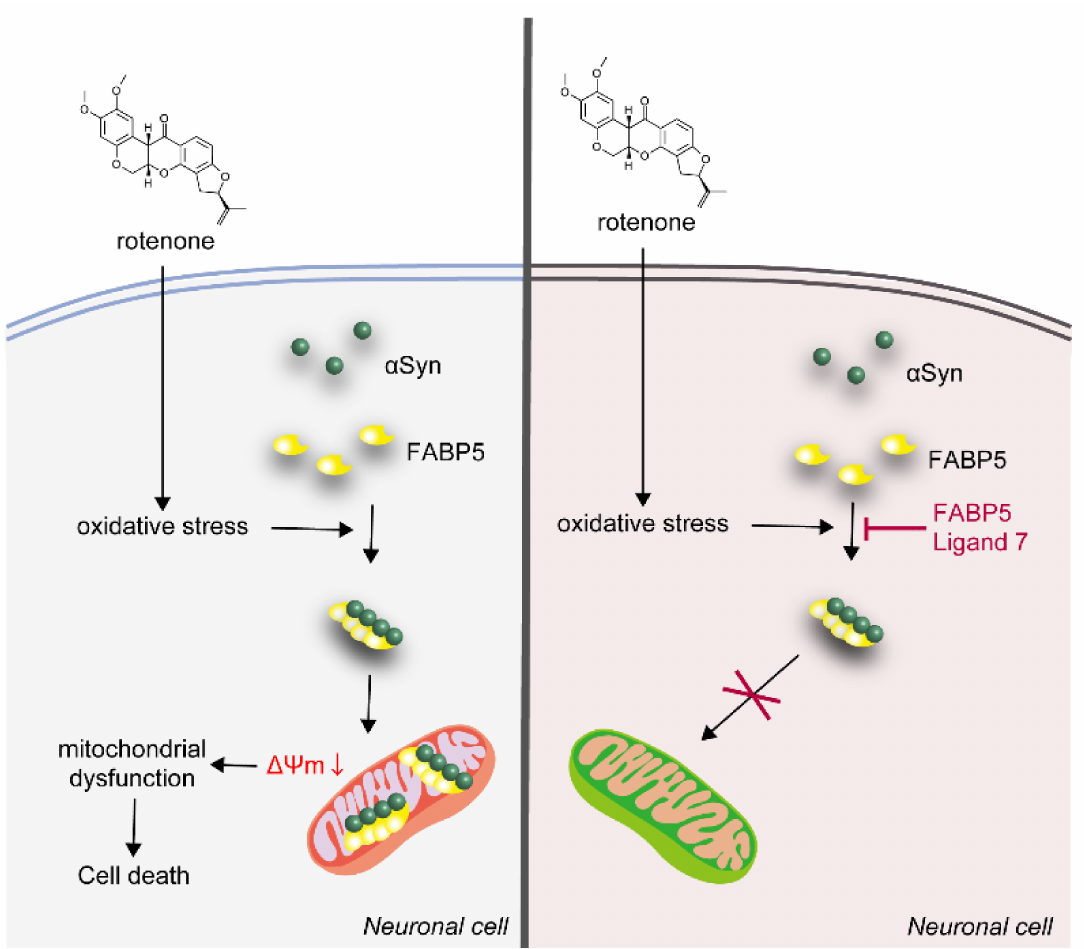
Figure 7. Schematic diagram of the mechanism by which α Syn/FABP5 aggregates aggravate mitochondrial dysfunction and induce neuronal cell apoptosis. FABP5 ligand 7 binds with FABP5 and blocks aggregate formation to attenuate neurotoxicity. ( Left ) when exposed to rotenone, α Syn accumulated with FABP5 to form oligomers and aggregates, which were further targeted to mitochondria. The reduced mitochondrial membrane potential indicated mitochondrial dysfunction which induced cell death. ( Right ) pharmacological inhibition of FABP5 by ligand 7 prevented α Syn/FABP5 aggregate formation, thereby rescuing neuronal